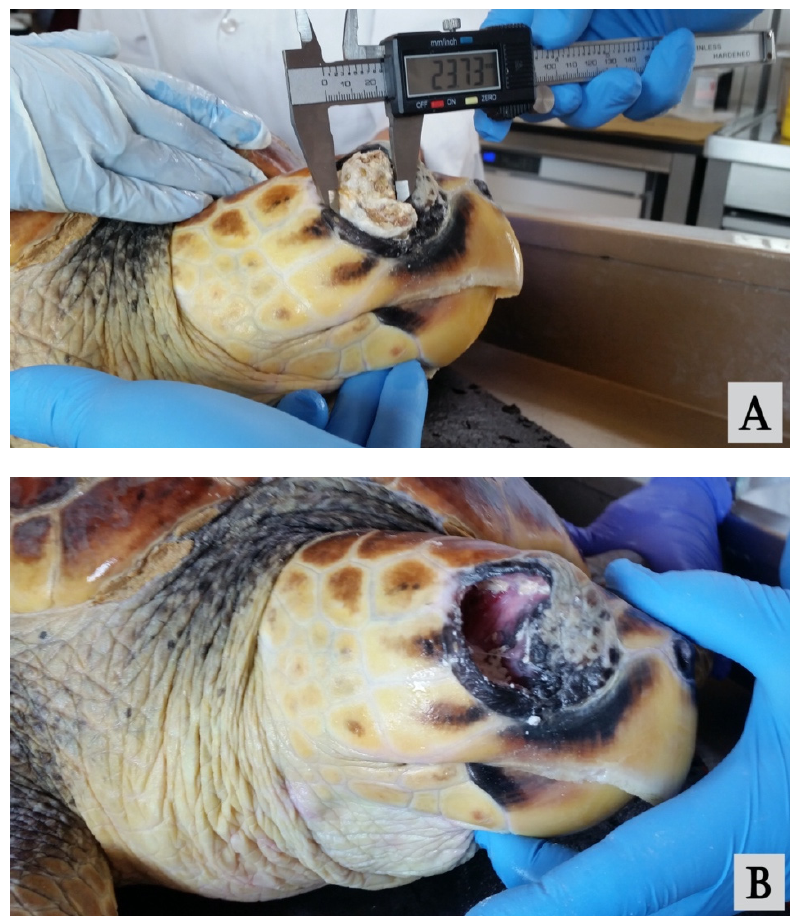
Figure 2. Dacryolith protruding through the eyelid ulcer ( A ) and free orbit space posterior to the ocular globe after removal ( B ).